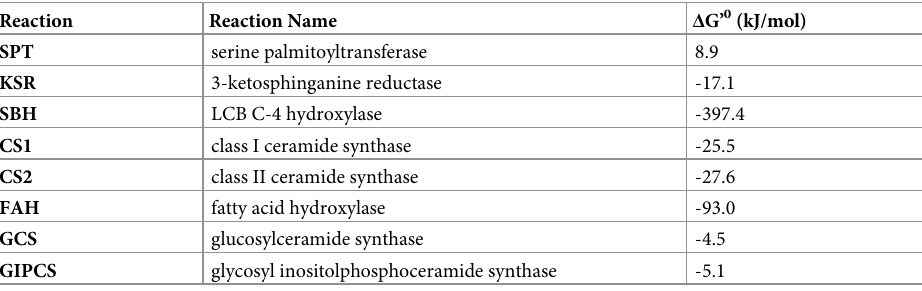
Table 1. Standard Gibbs free energy values for reactions in the sphingolipid pathway.